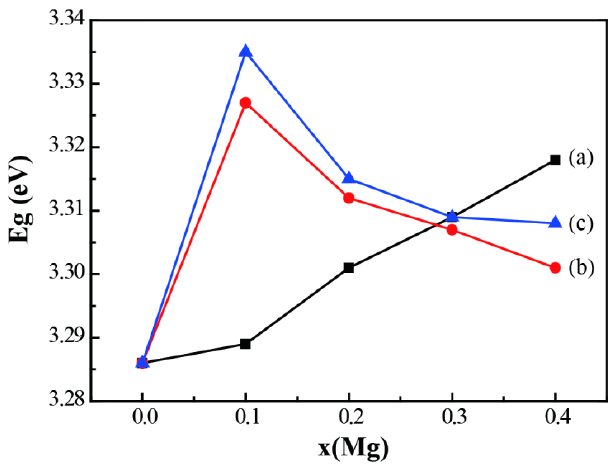
Figure 7. Band gap energy E g of pure and doped ZnO nanoparticles. ( a ) Zn 1− x Mg x O; ( b ) Zn 1−0.02− x Mg x B 0.02 O; ( c ) Zn 1−0.04− x Mg x B 0.04 O.